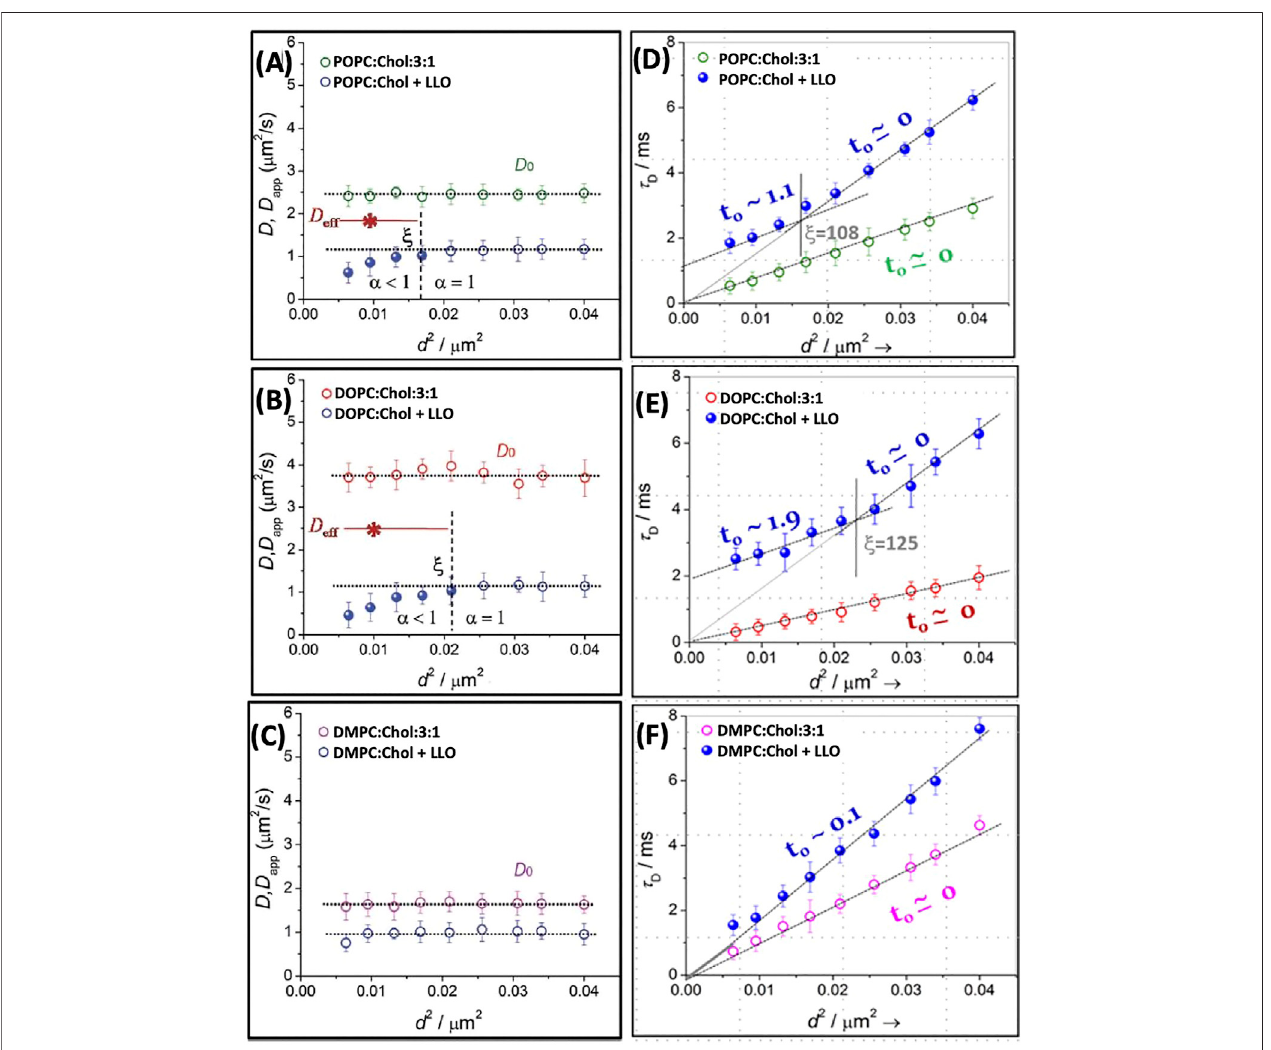
FIGURE7| Thediffusioncoef fi cients D and D app plottedasafunctionof d 2 forPOPC (A) ,DOPC (B) andDMPC (C) with25%Chol.Wehavereplottedtheresultsin theformof τ D vs. d 2 ( Panels D – F) .Thesolidlinesintherespectivepanelsarethelinear fi tusing Eq.10 andthedottedlinesaretheextrapolatedlinetoshowtheintercept. The vertical lines, in respective panels, demarcates the crossover length scale, ξ , separating different dynamical regimes whether Brownian or non-Brownian diffusion. Adapted from Sarangi et al.